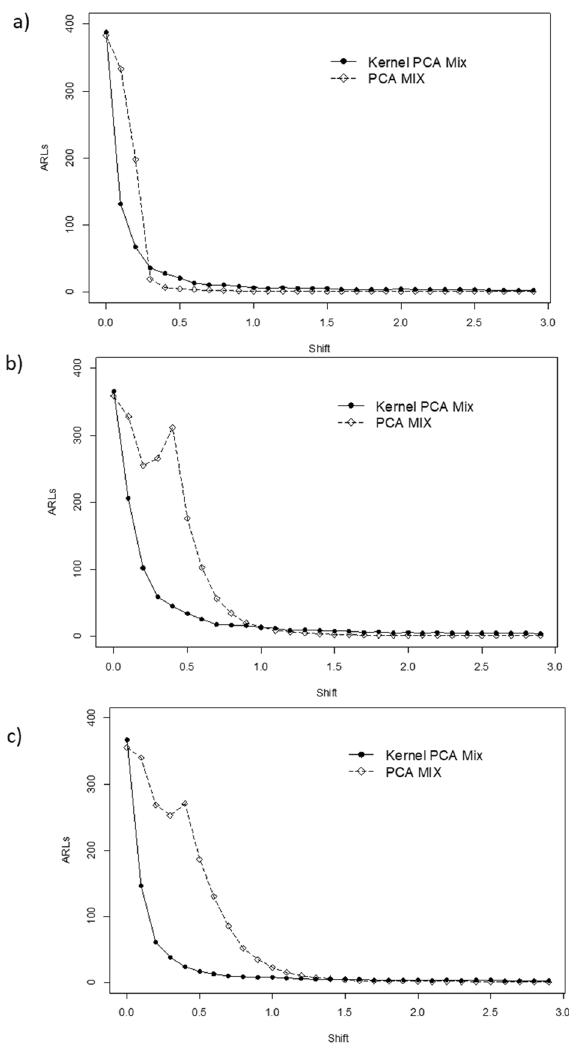
Figure 5. ARLs comparison between Kernel PCA Mix and PCA Mix charts with a balanced parameter of attribute characteristic for: ( a ) l = 2, ( b ) l = 3, and ( c ) l = 4.